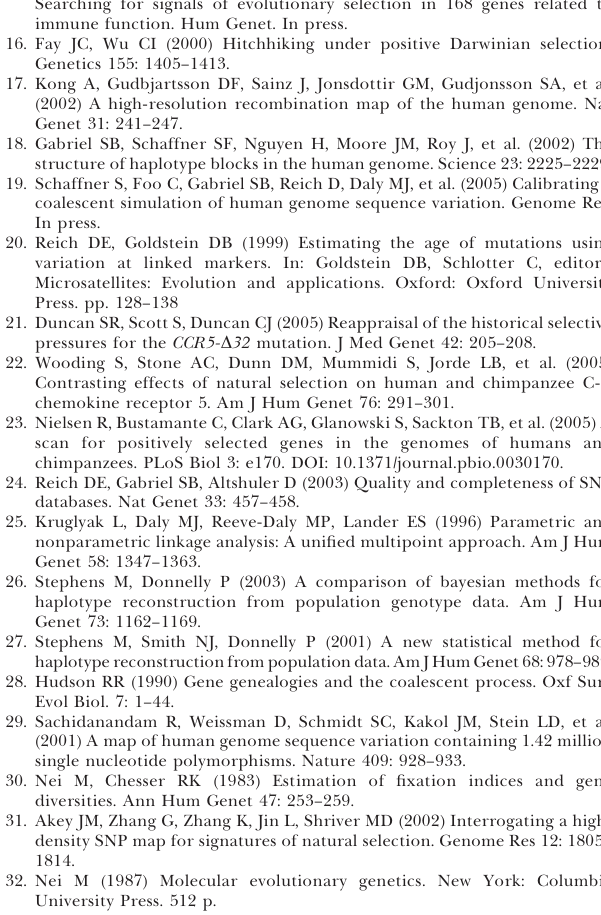
Figure S3. Haplotype Bifurcation Diagrams in European-Americans Found at DOI: 10.1371/journal.pbio.0030378.sg003 (231 KB DOC). Figure S4. The REHH versus Frequency Distribution at Matched Genetic Distance [17] Found at DOI: 10.1371/journal.pbio.0030378.sg004 (99 KB DOC). Figure S5. Estimating the Rate of Degradation of EHH Found at DOI: 10.1371/journal.pbio.0030378.sg005 (40 KB DOC). Figure S6. Remapping of Microsatellite Markers from First Study Given the Improved Genomic Maps Found at DOI: 10.1371/journal.pbio.0030378.sg006 (45 KB DOC). Figure S7. Microsatellite Genotyping Found at DOI: 10.1371/journal.pbio.0030378.sg007 (71 KB DOC). Figure S8. Comparison of Overall Genetic Diversity and Specific Haplotype EHH in Different Populations Found at DOI: 10.1371/journal.pbio.0030378.sg008 (38 KB DOC). Protocol S1. Recombination-Rate Estimates for CCR5 from Family- Based Linkage Studies (deCODE and Marshfield Maps), from Preliminary Sperm-Typing, and from Population Genetics (LDhat) Found at DOI: 10.1371/journal.pbio.0030378.sd001 (32 KB DOC). Table S1. Information for D 32 (rs333), 70 SNPs, and Two Micro- satellites Used in the Study Found at DOI: 10.1371/journal.pbio.0030378.st001 (30 KB XLS). Table S2. CCR5- D 32 EHH Values for Eight European-American Chromosomes versus the 32 Total Genotyped Chromosomes Found at DOI: 10.1371/journal.pbio.0030378.st002 (23 KB DOC).